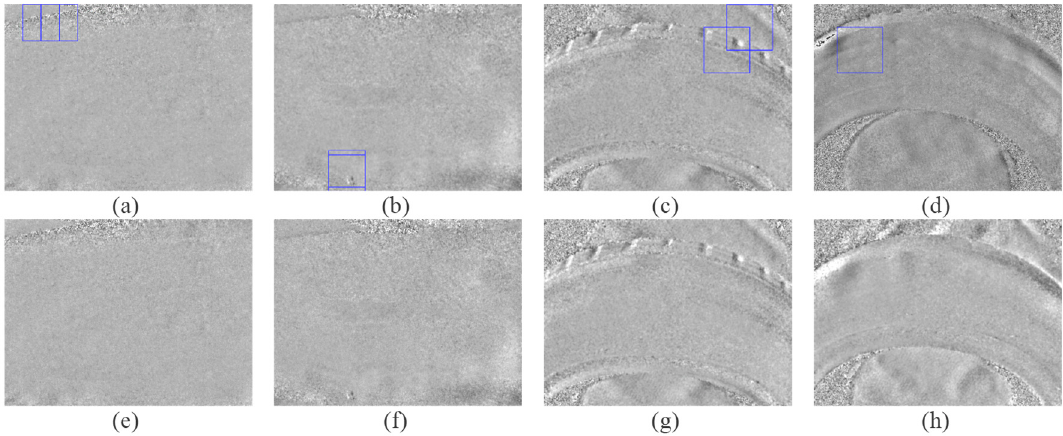
Figure 9. Chang’s model misclassification results [13] and the Proposed Hybrid Faster Region-based Convolutional Neural Networks Model. ( a – d ) diagnosis outcomes of tire bubble defects using Chang’s model, ( e – h ) the Proposed Hybrid Faster Region-based Convolutional Neural Networks Model’s bubble defects detection results.